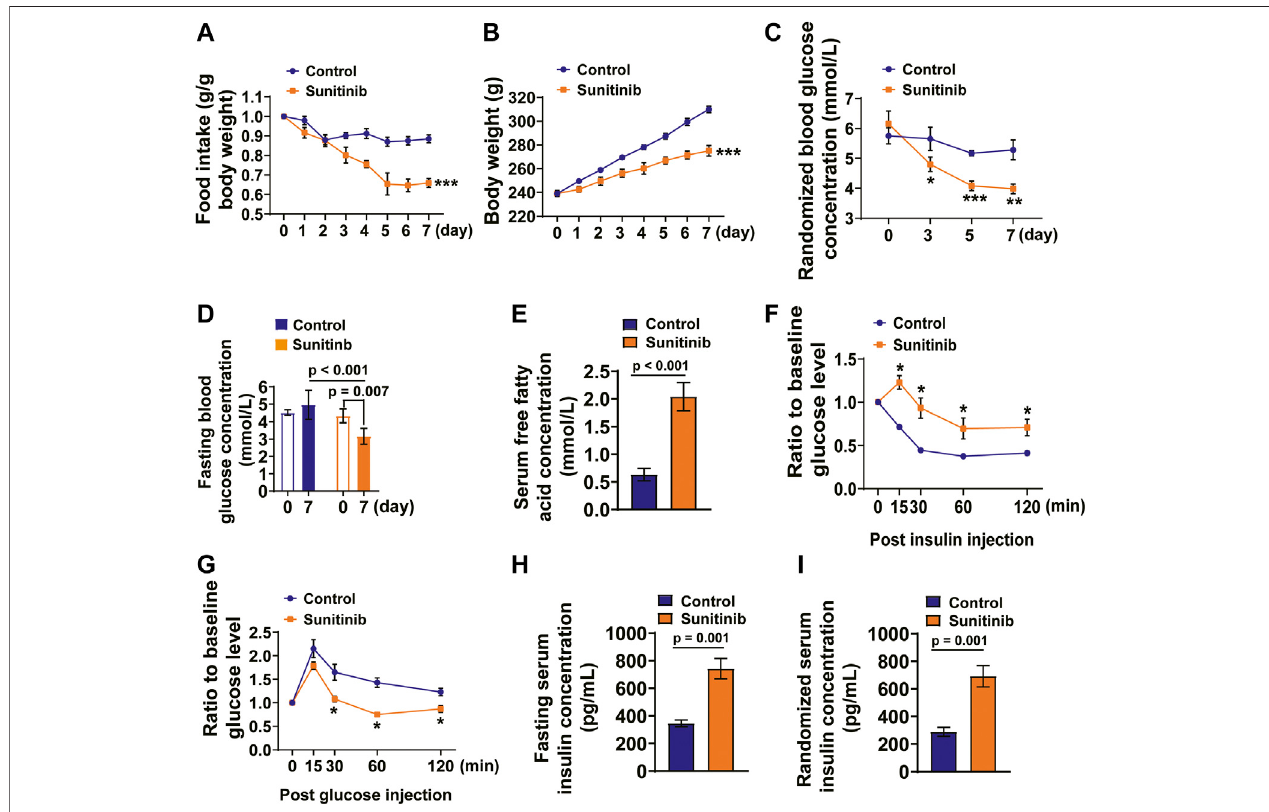
FIGURE 2 | Sunitinib administration led to metabolism disorders and insulin resistance in SD rats. (A) Average daily food intake was dramatically decreased by sunitinibadministration( *** p < 0.001vs.control; n (cid:2) 6rats/group). (B) Averagedailybodyweightwassigni fi cantlydecreasedbysunitinibadministration( *** p < 0.001vs.control; n (cid:2) 6rats/group). (C) RBGconcentrationdetectedonday3,5,7incontrolratsorsunitinib-treatedrats(* p < 0.05vs.control;** p < 0.01vs.control,*** p < 0.001vs.control; n (cid:2) 6rats/ group). (D) FBGconcentrationmeasuredonday7incontrolratsorsunitinib-treatedrats( p (cid:2) 0.007vs.baseline; p < 0.001vs.controlatday7; n (cid:2) 6rats/group). (E) Serum FFAconcentration( p < 0.001vs.control; n (cid:2) 9rats/group)detectedonday7incontrolratsortheratstreatedwithsunitinib. (F) Onthe7 th day,ITTassay(intraperitonealinjectionof recombinanthumaninsulin1.5 mUg − 1 BW)performedincontrolandsunitinib-treatedratsthatwerefastedfor5 h;thestatisticalresultspresentedasfollows:werepresenttested valueobtainedfromeachrat,measuredattheindicatedtimepoints,wasnormalizedtoitsownbaselinevaluehours(* p < 0.05vs.control; n (cid:2) 6rats/group) (G) Glucosetolerance test (intraperitoneal injection of glucose 1.2 mg g − 1 BW) performed on day 7 in control and sunitinib-treated rats were fasted for 5 h; the statistical results presented as follows: tested value obtained from each rat, measured at the indicated time points, was normalized to its own baseline value (* p < 0.05 vs. control; n (cid:2) 6 rats/group). (H) Fasting serum insulinconcentrationwasdetectedonday7incontrolandsunitinib-treatedrats( p (cid:2) 0.001vs.control; n (cid:2) 7rats/group). (I) Randomizedseruminsulinconcentrationdetectedon day 7 in control and sunitinib-treated rats ( p (cid:2) 0.001 vs. control; n (cid:2) 7